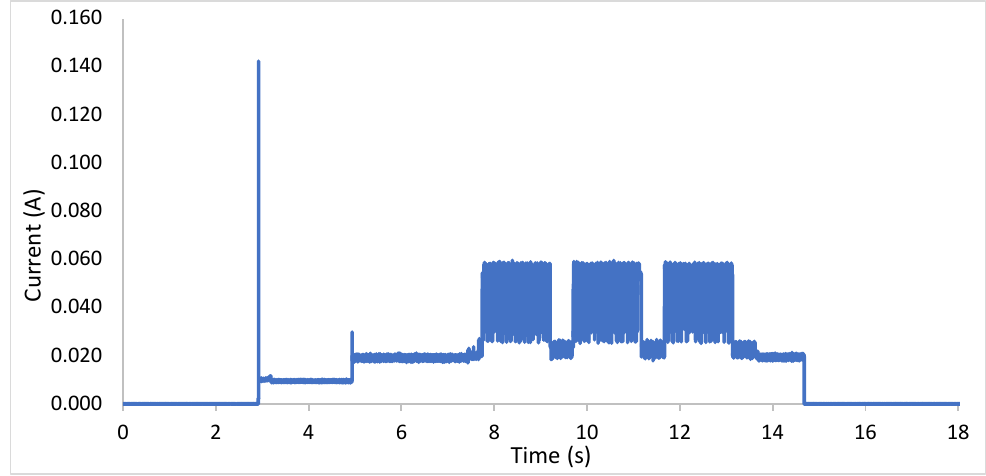
Figure 5. Device consumption per data transmission cycle.